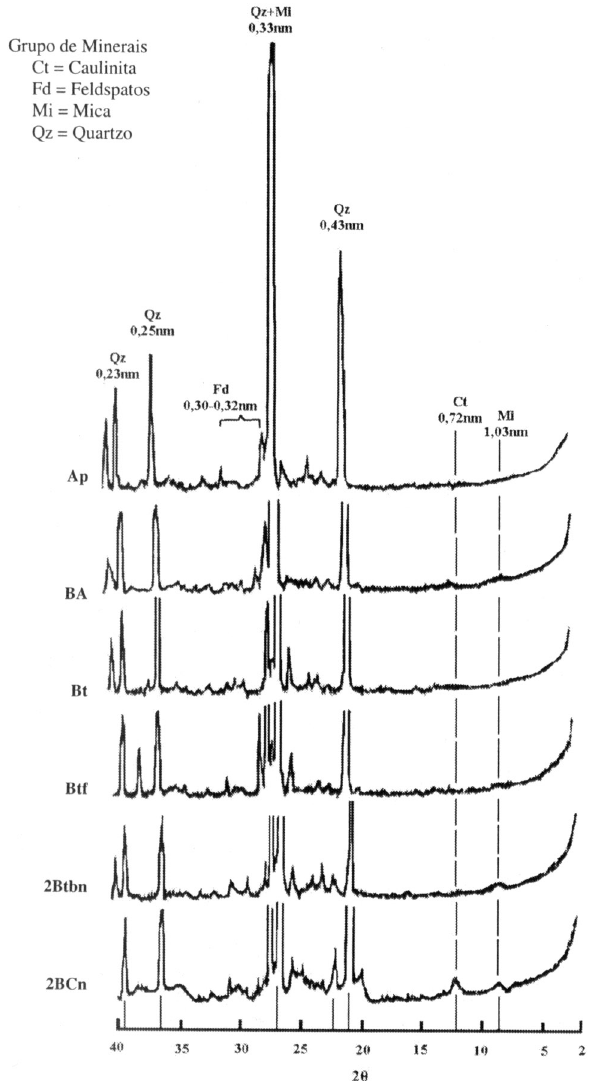
(saturada com K) do Perfil 3 - Argissolo Amarelo eutrófico plíntico planossólico